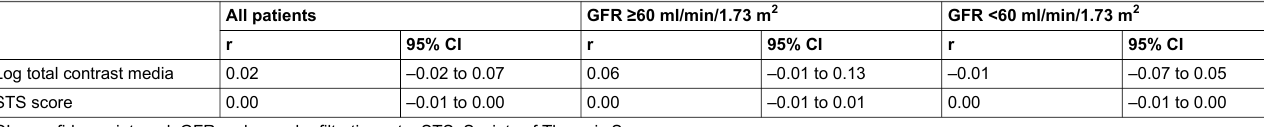
Table 5: Impact of contrast media as a predictor of change of creatinine within 72 hours after transcatheter aortic valve implantation. All